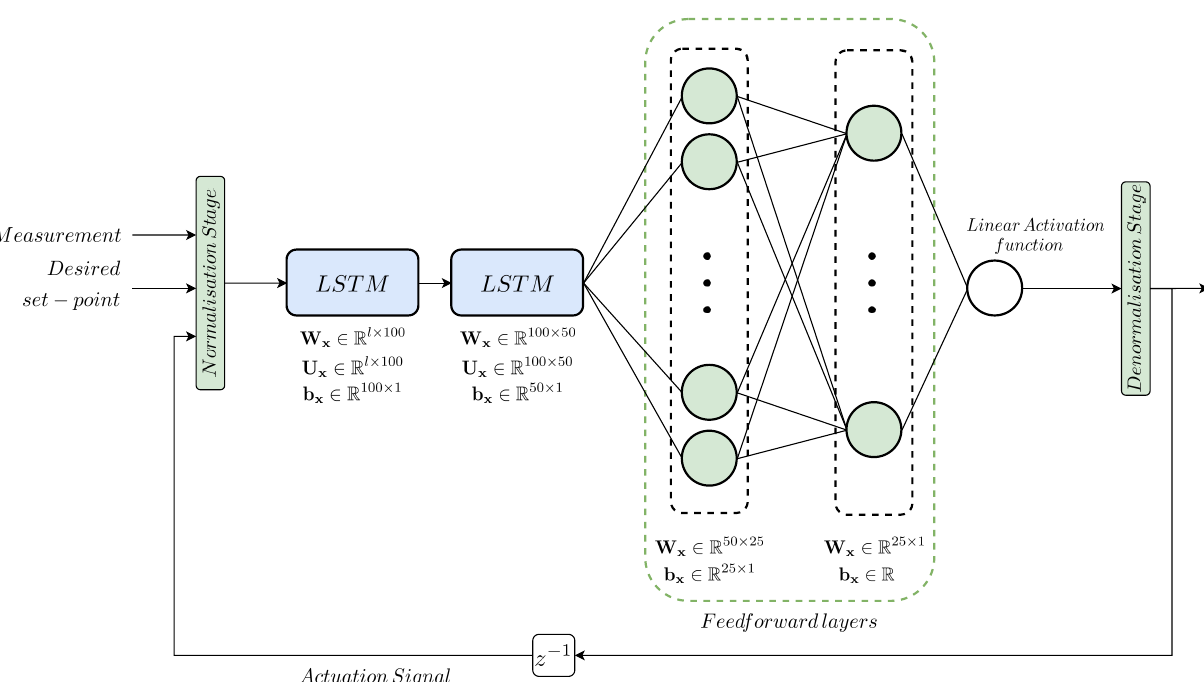
Figure 5. LSTM-based net considered in the LSTM-based Controller. l corresponds to the number of inputs, which in this case is set to three measurements: the measured concentration of interest, S O ,5 ( t ) or S NO ,2 , its set-point, S O ,5 ( t ) , and the actuation variable, K ( t − 1 ) or Q a ( t − 1 ) . S NO ,2 La ,5 set − point The prediction performance of both structures has been computed in terms of the difference between the predicted actuation variables and the expected ones (remember that the DO LSTM-based PI predicts the K La ,5 ) , whereas the NO one predicts the Q a . Five metrics are adopted, the Root Mean Squared Error (RMSE), the Mean Absolute Error (MAE), the Mean Average Percentage Error (MAPE) the determination coefficient ( R 2 ),